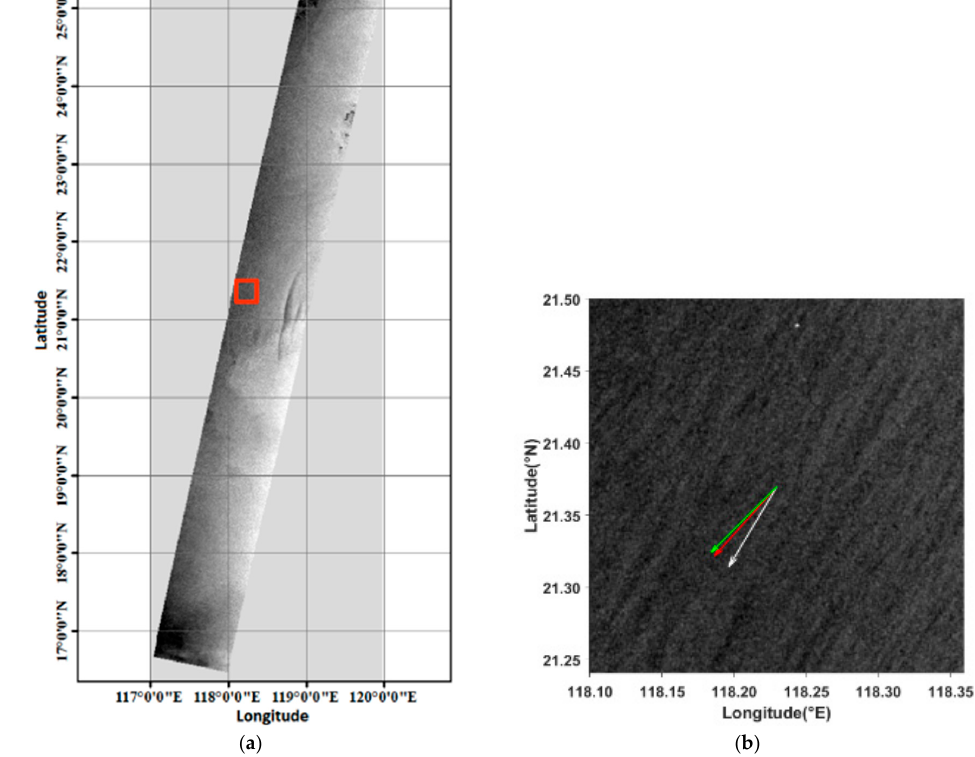
Figure 2. ( a ) An Envisat advanced synthetic aperture radar (ASAR) image acquired at 02:06 on 14 October 2007 in VV polarization with a resolution of 75 m. ( b ) The subimage which is indicated by the red box in ( a ). White, red and green arrows indicate wind directions obtained from improved local gradients (ILG) method, European Centre for Medium-Range Weather Forecast (ECMWF) and Cross-Calibrated Multi-Platform (CCMP), respectively. H x and H y are shown in Figure 3 in frequency domain, and their amplitudes are indicated by different colors. The computed g x and g y of the image in Figure 2b are shown in Figure 4 in spatial domain and different colors indicate different values of the gradient component.